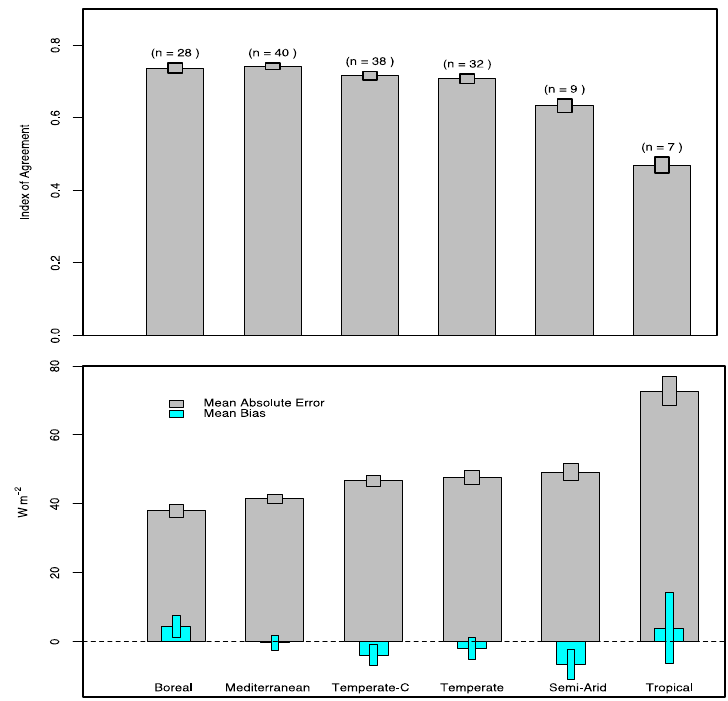
Figure 4. Agreement between daytime (sunrise to sunset, eight-day time scale) MODIS and measured net-radiation in six different climate types. Temperate-C denotes Temperate-Continental. Number of field sites are shown atop the bars in the upper panel.